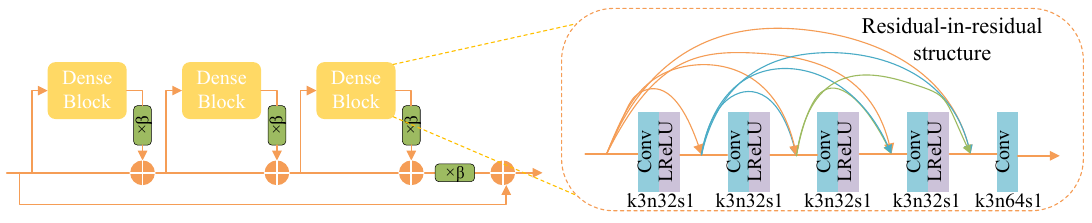
Figure 3. Residual-in-Residual Dense Block (RRDB) with residual scaling parameter β . In each convolutional layer, k , n , and s represent kernel size, number of feature maps, and stride.